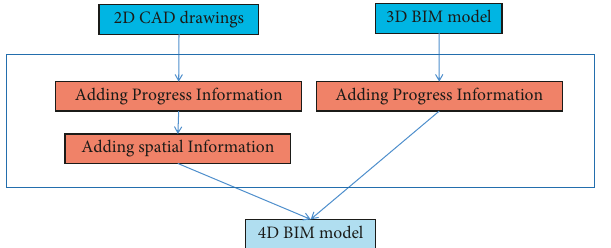
Figure 2: Construction method from design scheme to a four- dimensional